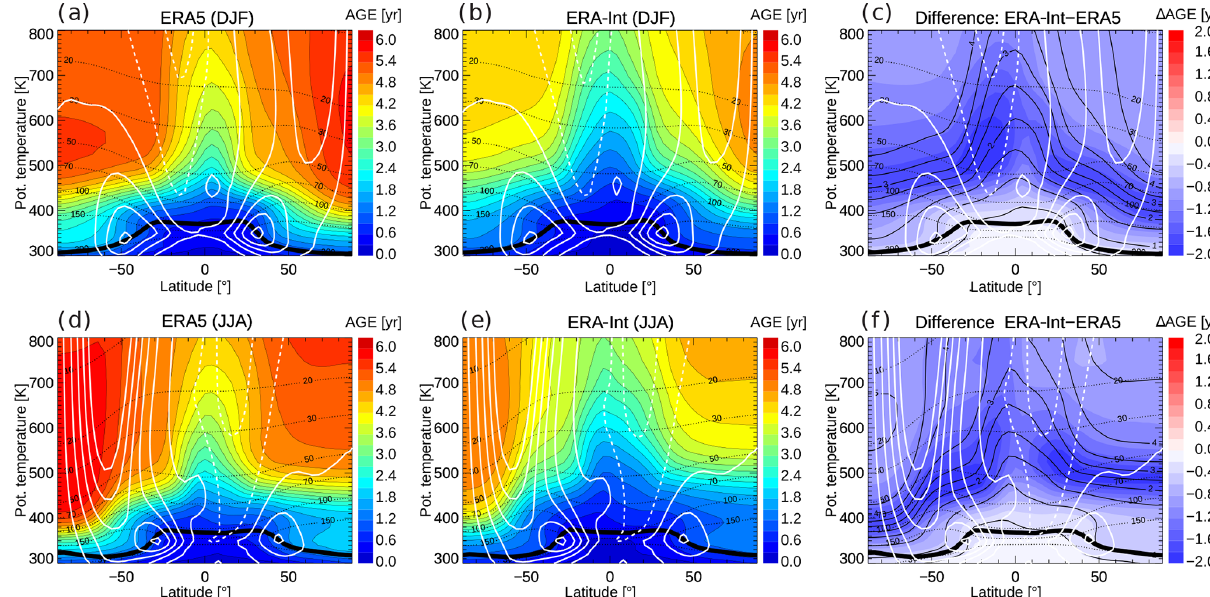
Figure 3. Mean age climatology (1989–2018) for boreal winter (December–February, DJF) from ERA5 (a) , ERA-Interim (b) , and the difference (c) . Panels (d) – (f) are the same but for boreal summer (June–August, JJA). White contours show zonal wind (in ± 10m/s steps; easterly wind dashed), the thin dashed black lines show pressure levels, and the thick black line shows the (WMO lapse rate)